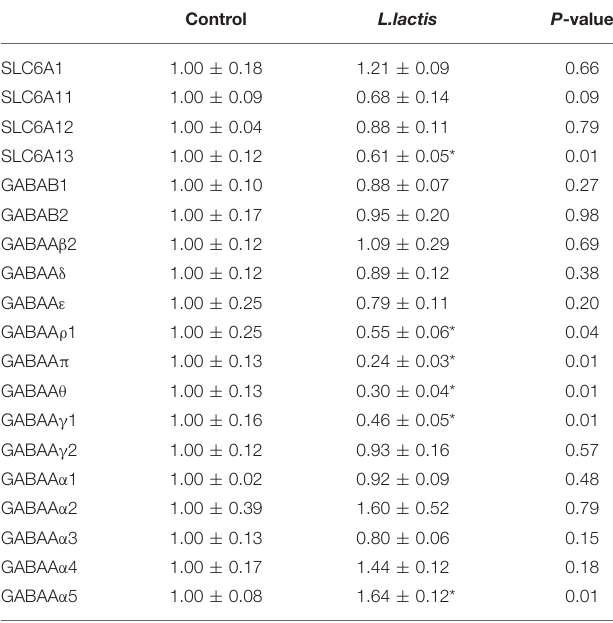
TABLE 2 | Expression of GABAergic system in the ilea of piglets. Control L.lactis P